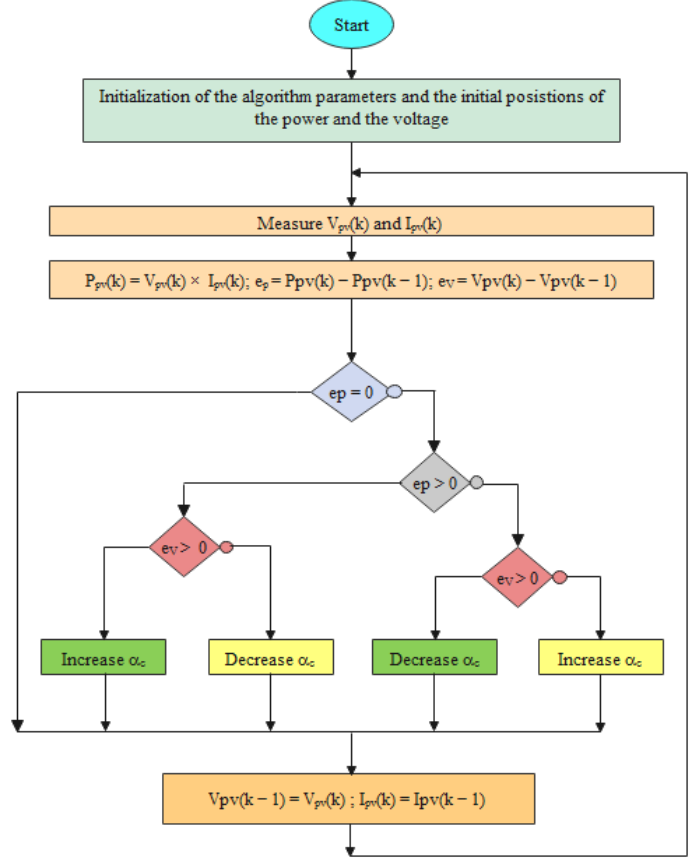
Figure 6. Flowchart of the P & O MPPT algorithm.